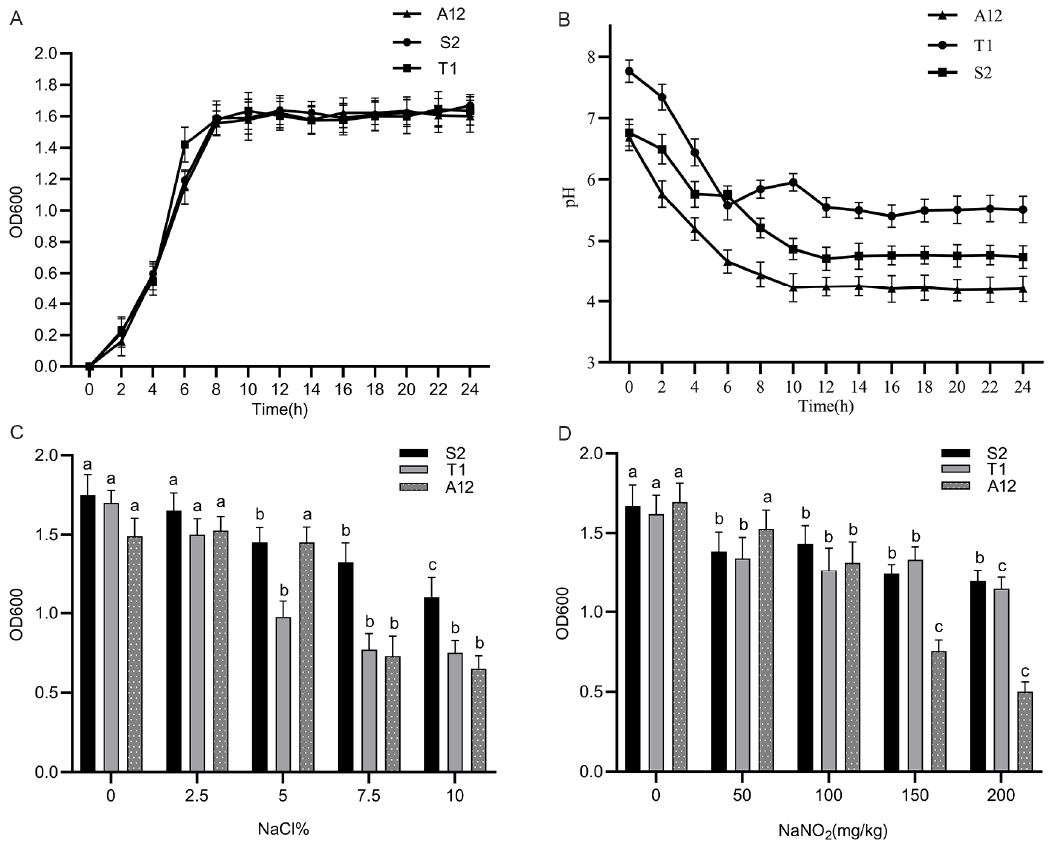
Figure 1. Evaluation of the growth and tolerance of the experimental strains. ( A ): growth curve; ( B ): pH; ( C ): salt tolerance; ( D ): nitrite resistance. a,b,c: different letters indicate significant differences in different salt and nitrite concentration environments in the same strain ( p < 0.05).